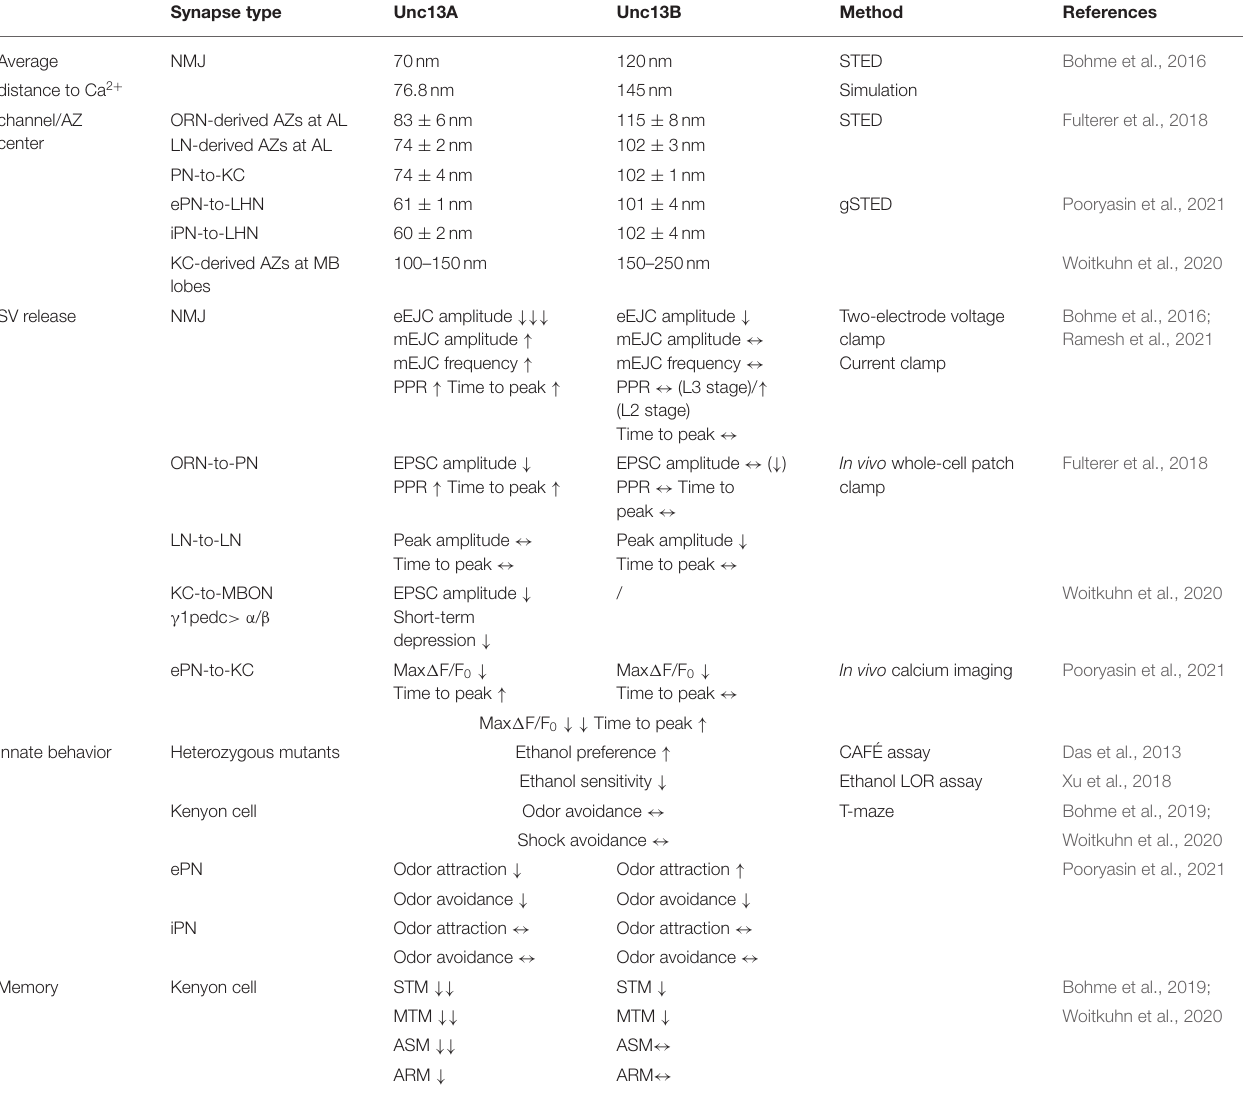
TABLE 1 | Unc13A vs. Unc13B in Ca 2 + channel coupling distance and functions in Drosophila